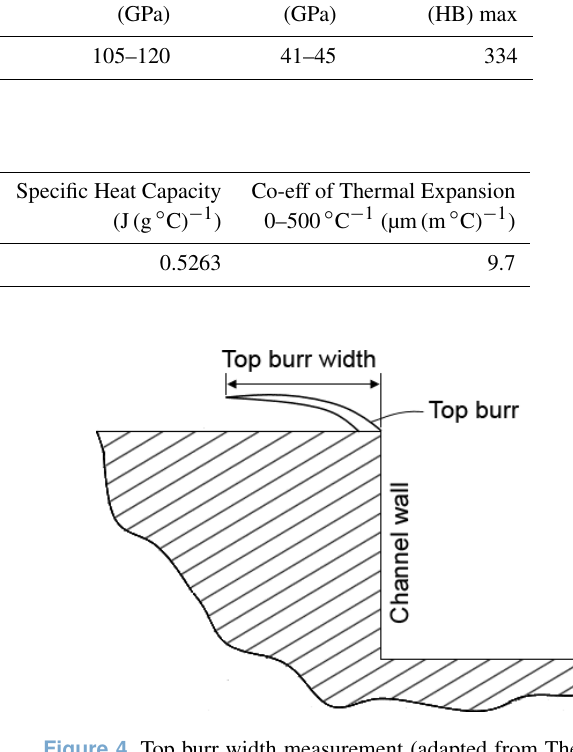
Figure 4. Top burr width measurement (adapted from Thepsonthi and Özel,